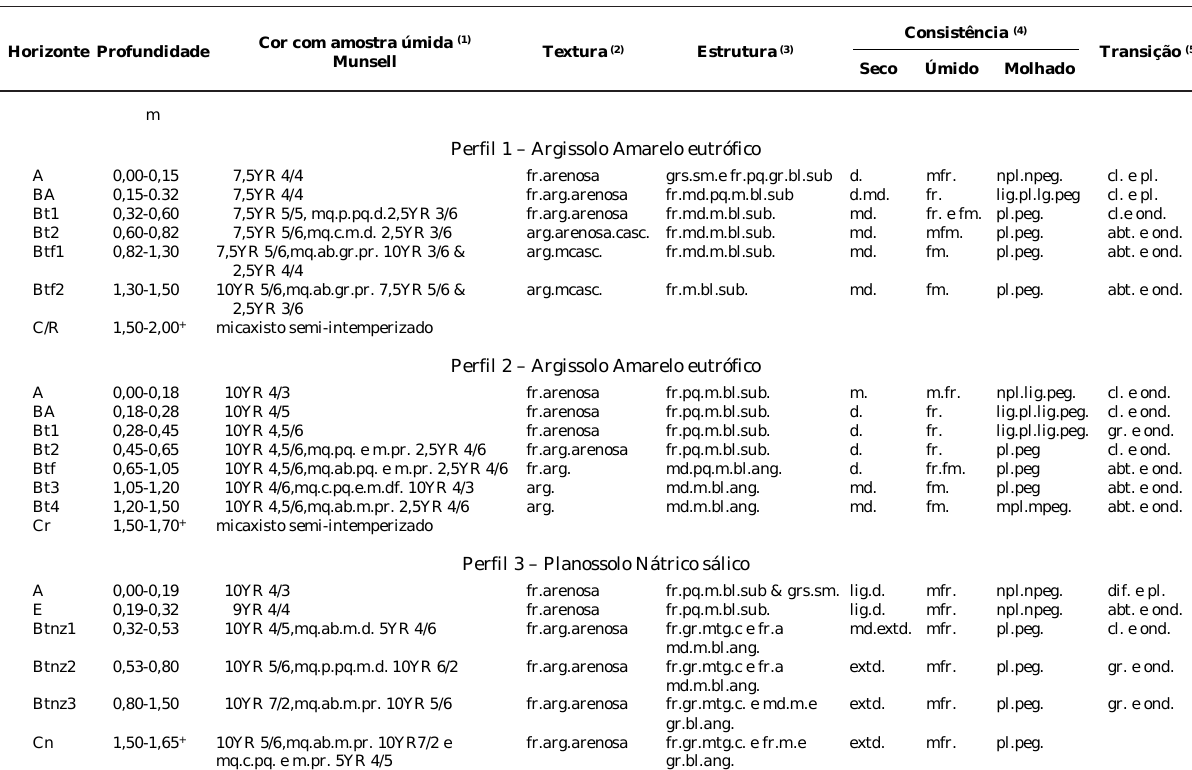
extd. mfr. pl.peg. gr. e ond. fr.arg.arenosa fr.gr.mtg.c. e fr.m.e extd. mfr. gr.bl.ang.